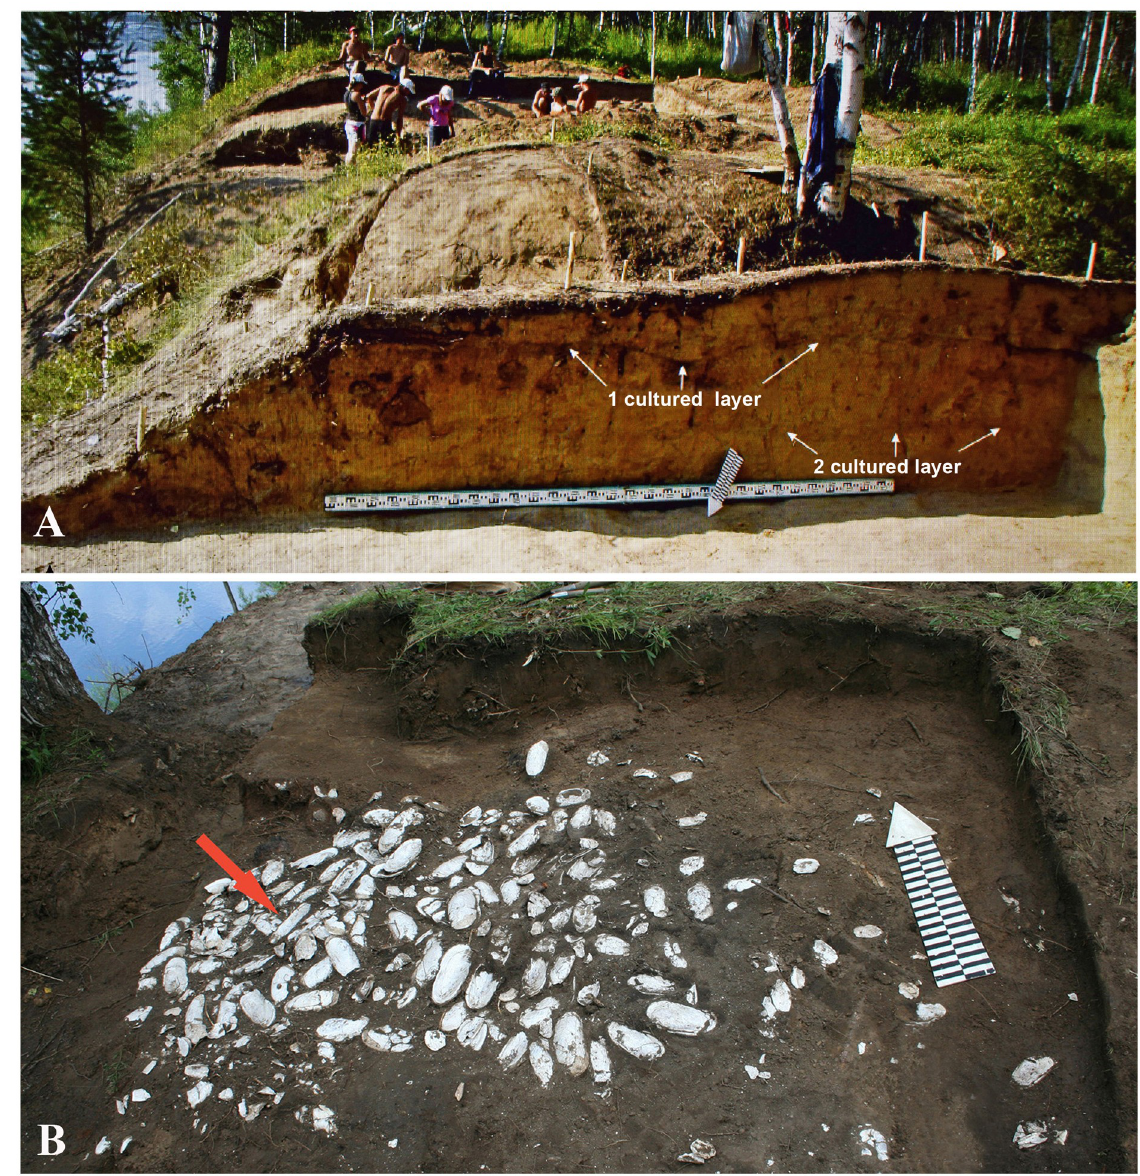
Fig 3. Archaeological excavations in the Proezzhaya 1 Fortress on the bank of the Shilka River. A –stratigraphic section of the excavation wall 47, in the background–excavation deposits of the dwelling 32, B –excavation of the outside slope bank of defensive fortification with clean layer of pearl mussel shells ( Lanceolaria shells indicated by red